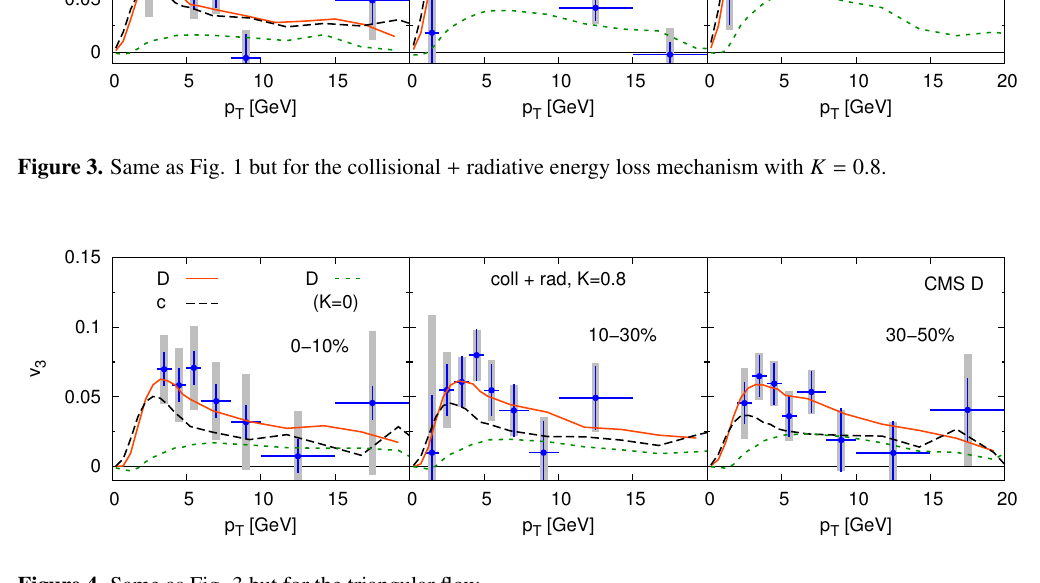
means their flow vanishes. The corresponding D meson flow is then only stemming from coalescence, since hadronic interactions are not included in our